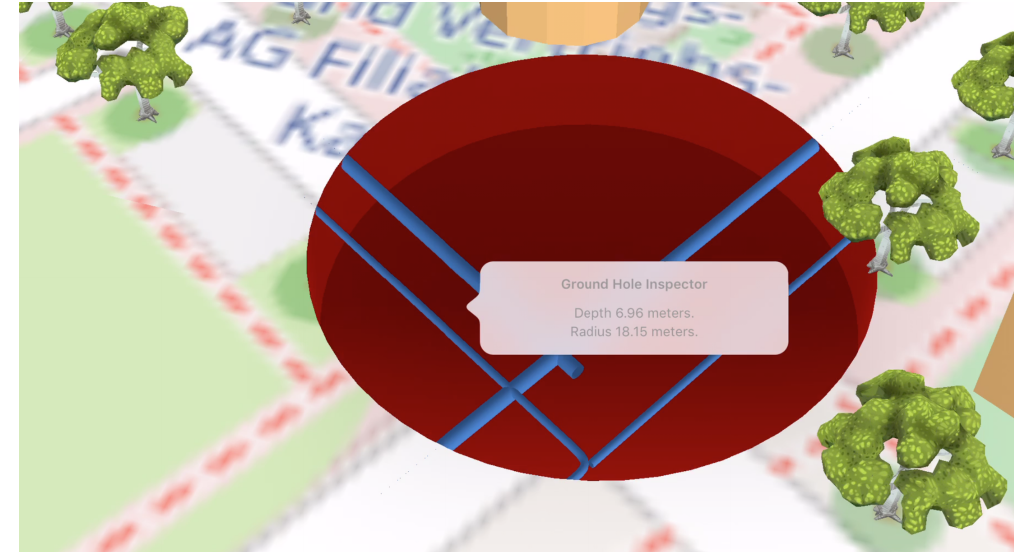
Figure 18. Different ground hole styles are being tested as future development of the project. In the picture a “cartoonish” rounded hole for pipe inspection.